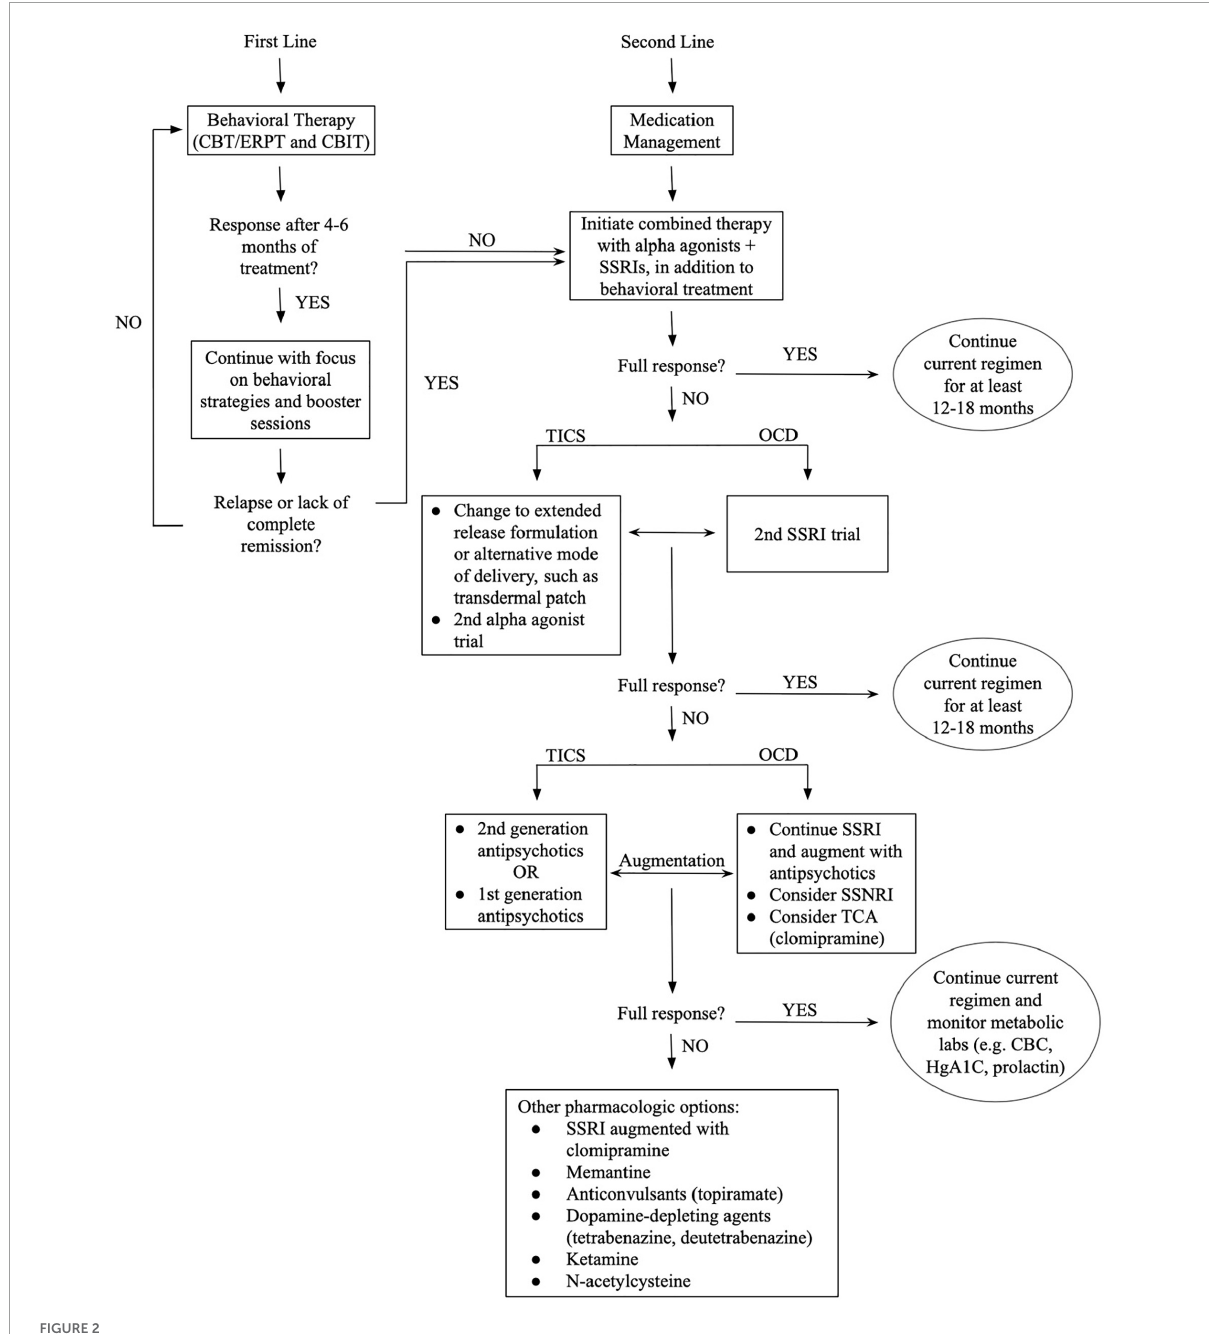
FIGURE2 Proposed treatment algorithm for patients with